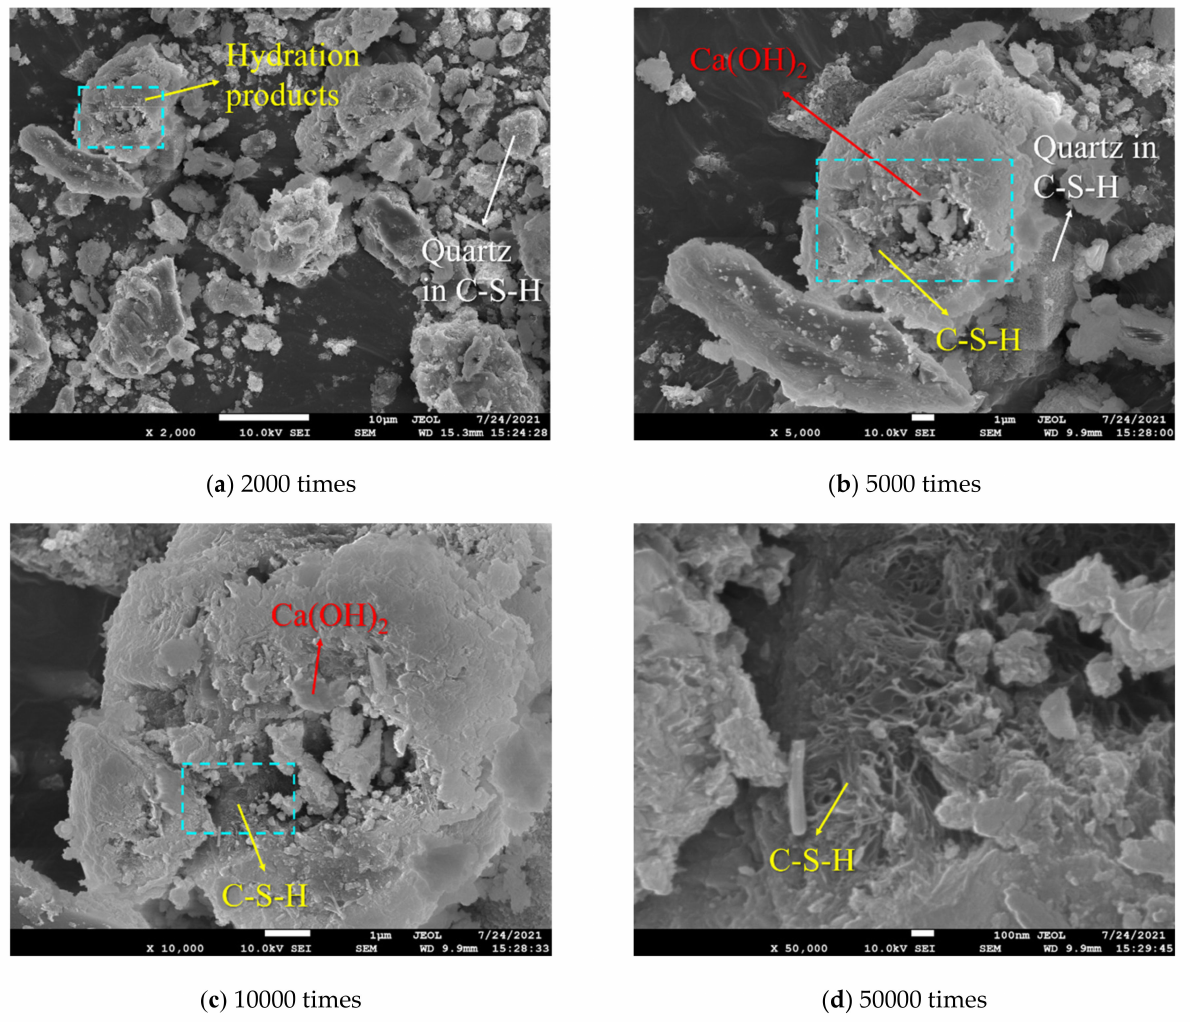
Figure 10. SEM micrographs of the sample having 9% expansive agent and 10% quartz sand at different